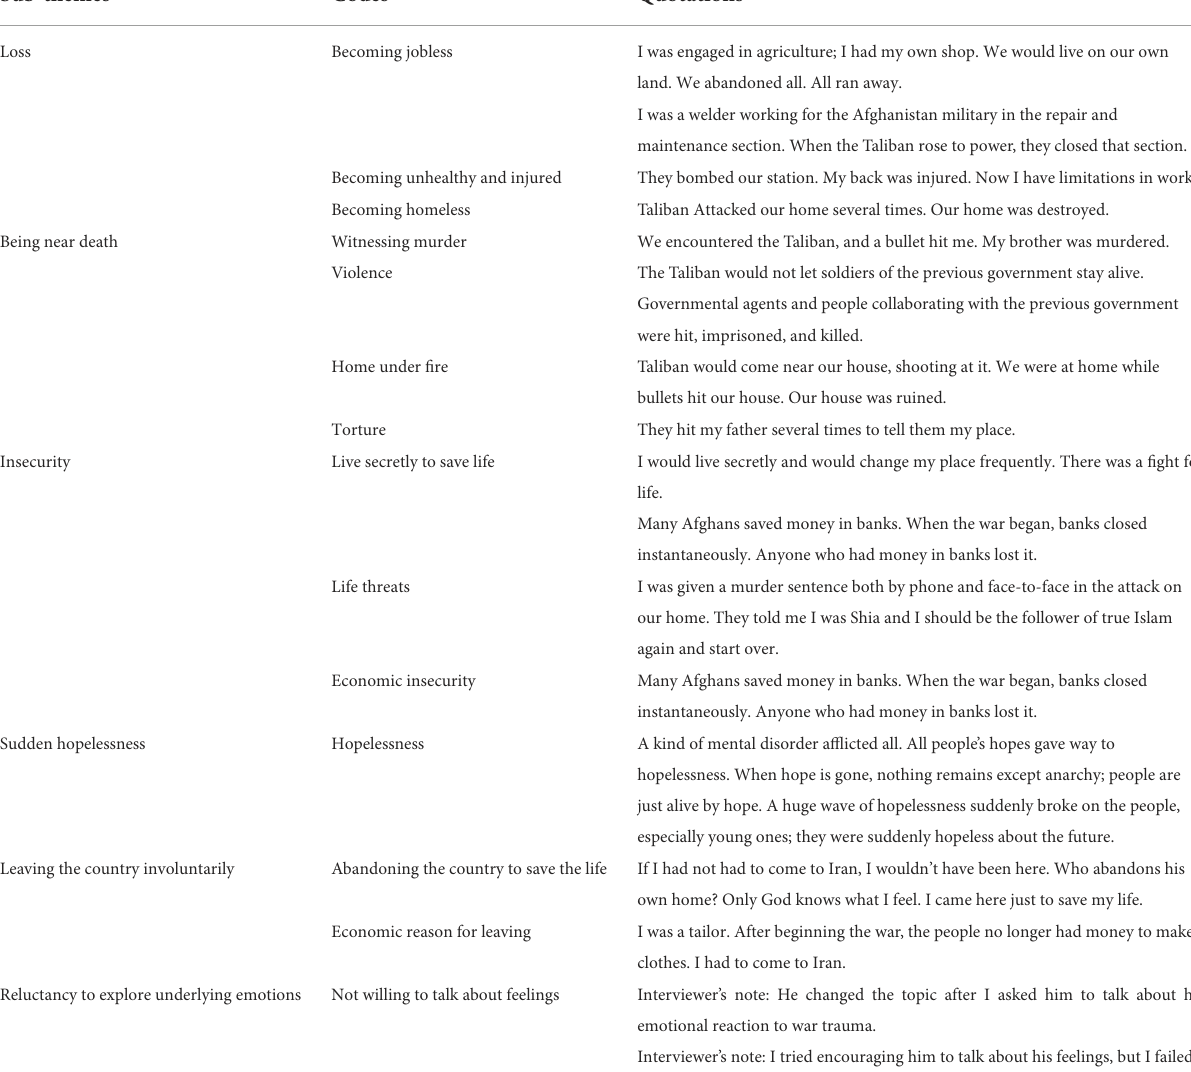
TABLE 1 Sub-themes, codes, and quotations of the Tsunami of suffering